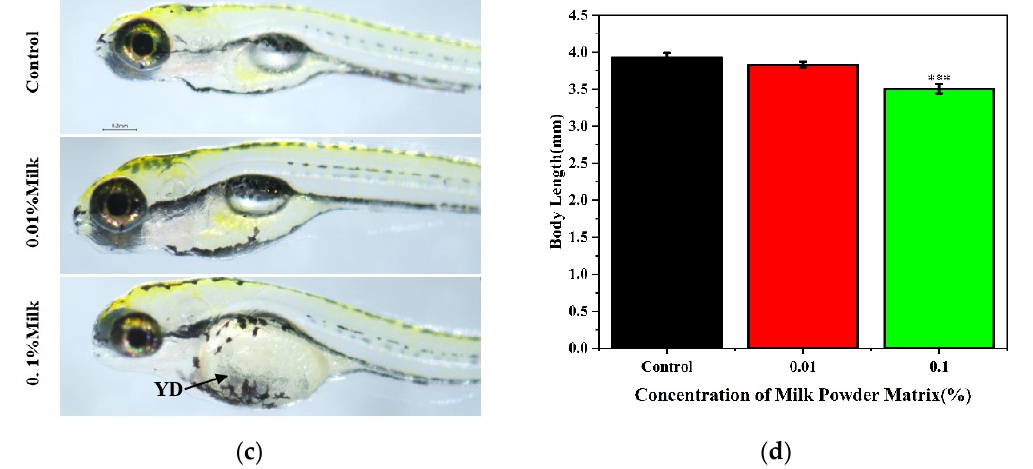
Figure 3. Effect of different concentrations of milk powder matrix incubation for 120 h on zebrafish larvae. ( a ) Survival rate of zebrafish embryos cultured with different concentrations of milk powder matrix; ( b ) Hatching rate of zebrafish embryos cultured with different concentrations of milk powder matrix; ( c ) Development of zebrafish larvae cultured with low concentration milk powder matrix; ( d ) Body length of zebrafish larvae cultured with low concentration of milk powder matrix. Abbreviations: Milk, milk powder matrix. *** p < 0.001 vs. control.